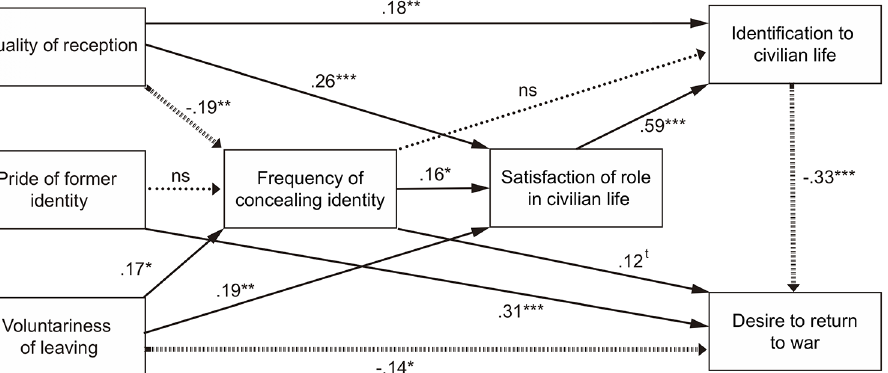
Figure 2. Predicted and final model of the paths associated concealment of former identity with its antecedents and its